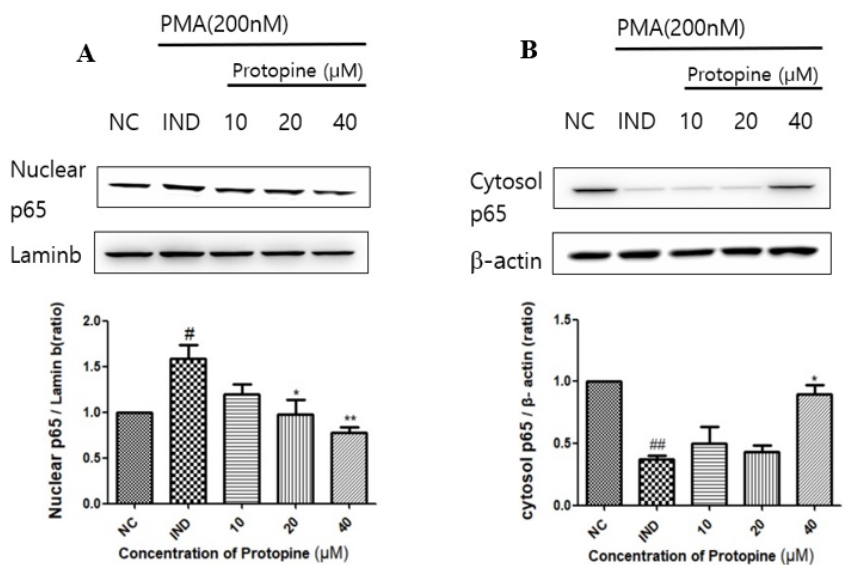
Figure 1. Protopine regulated I- κ B α translocation in PMA-stimulated HepG2 cells. ( A ) Western blot analysis of time-dependent I - κ B α phosphorylation after treatment with PMA 200 nM in HepG2 cells. ( B ) Cells were pretreated with protopine 40 μ M for 1 h and then treated with PMA 200 nM for 24 h. The level of I - κ B α protein phosphorylation was determined by Western blot. The results are presented as the means ± SD. # p < 0.05 indicates significantly different from the normal control. * p < 0.05 indicate a significant difference from the PMA group. NC, normal control.